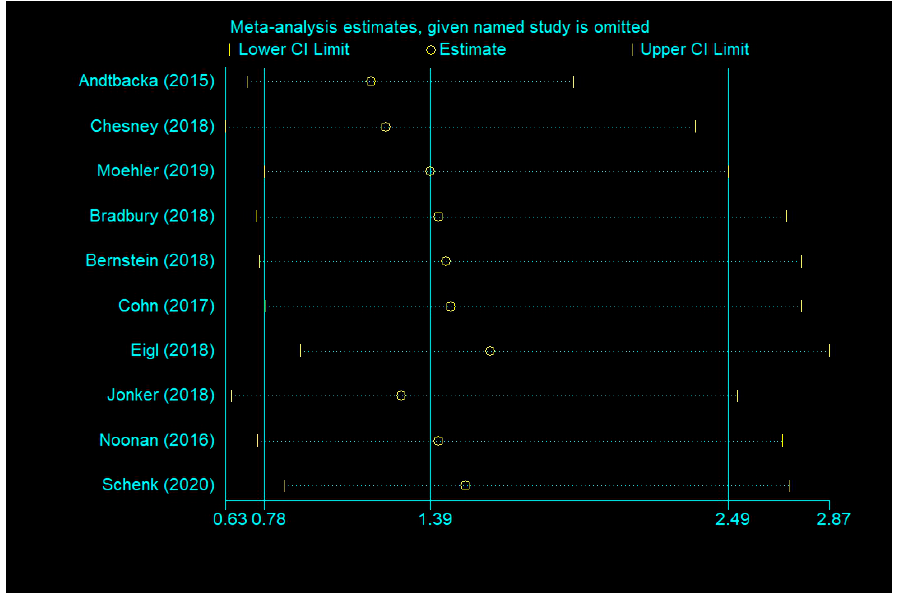
Figure 9. Sensitivity analysis of ORR.